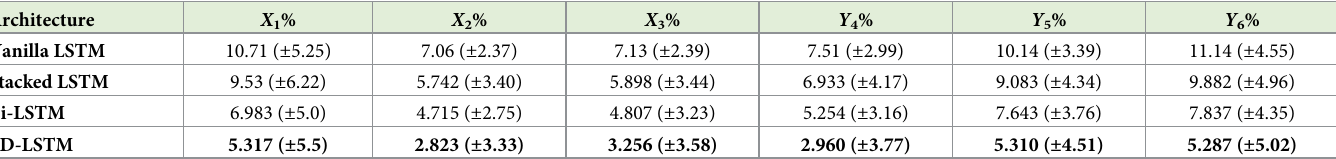
Table 4. Leave-one-out cross validation test error based on the NRMSE (%) at the PWS and 5km.h -1 combined. Architecture X 1